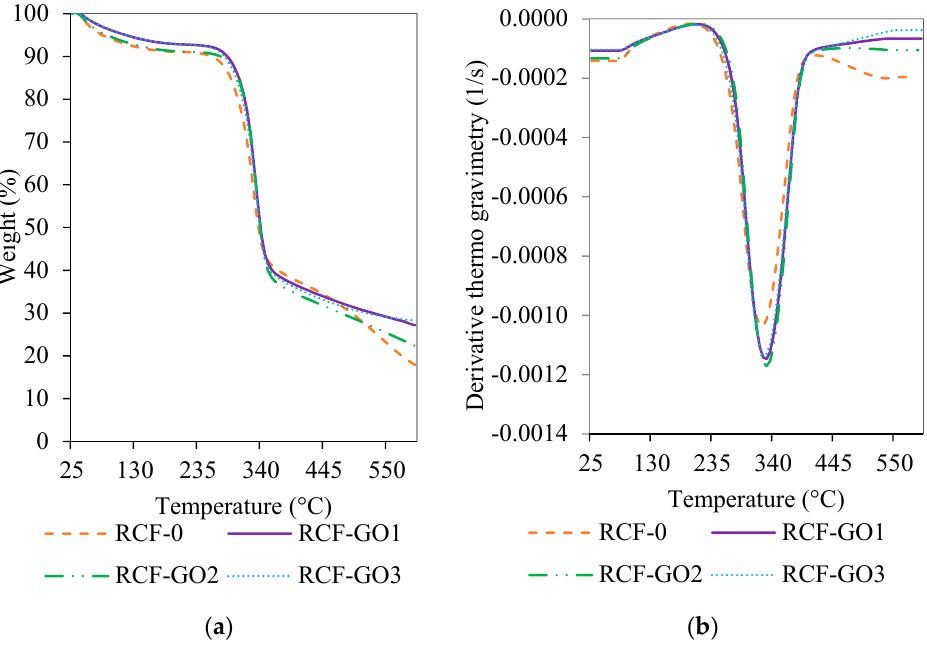
Figure 8. TGA curves of ( a ) RCF–GO with different GO concentrations and ( b ) differential thermo- gravimetry (DTG) curve of RCF–GO with different GO concentrations. Table 2. Thermal degradation of RCF–GOs.